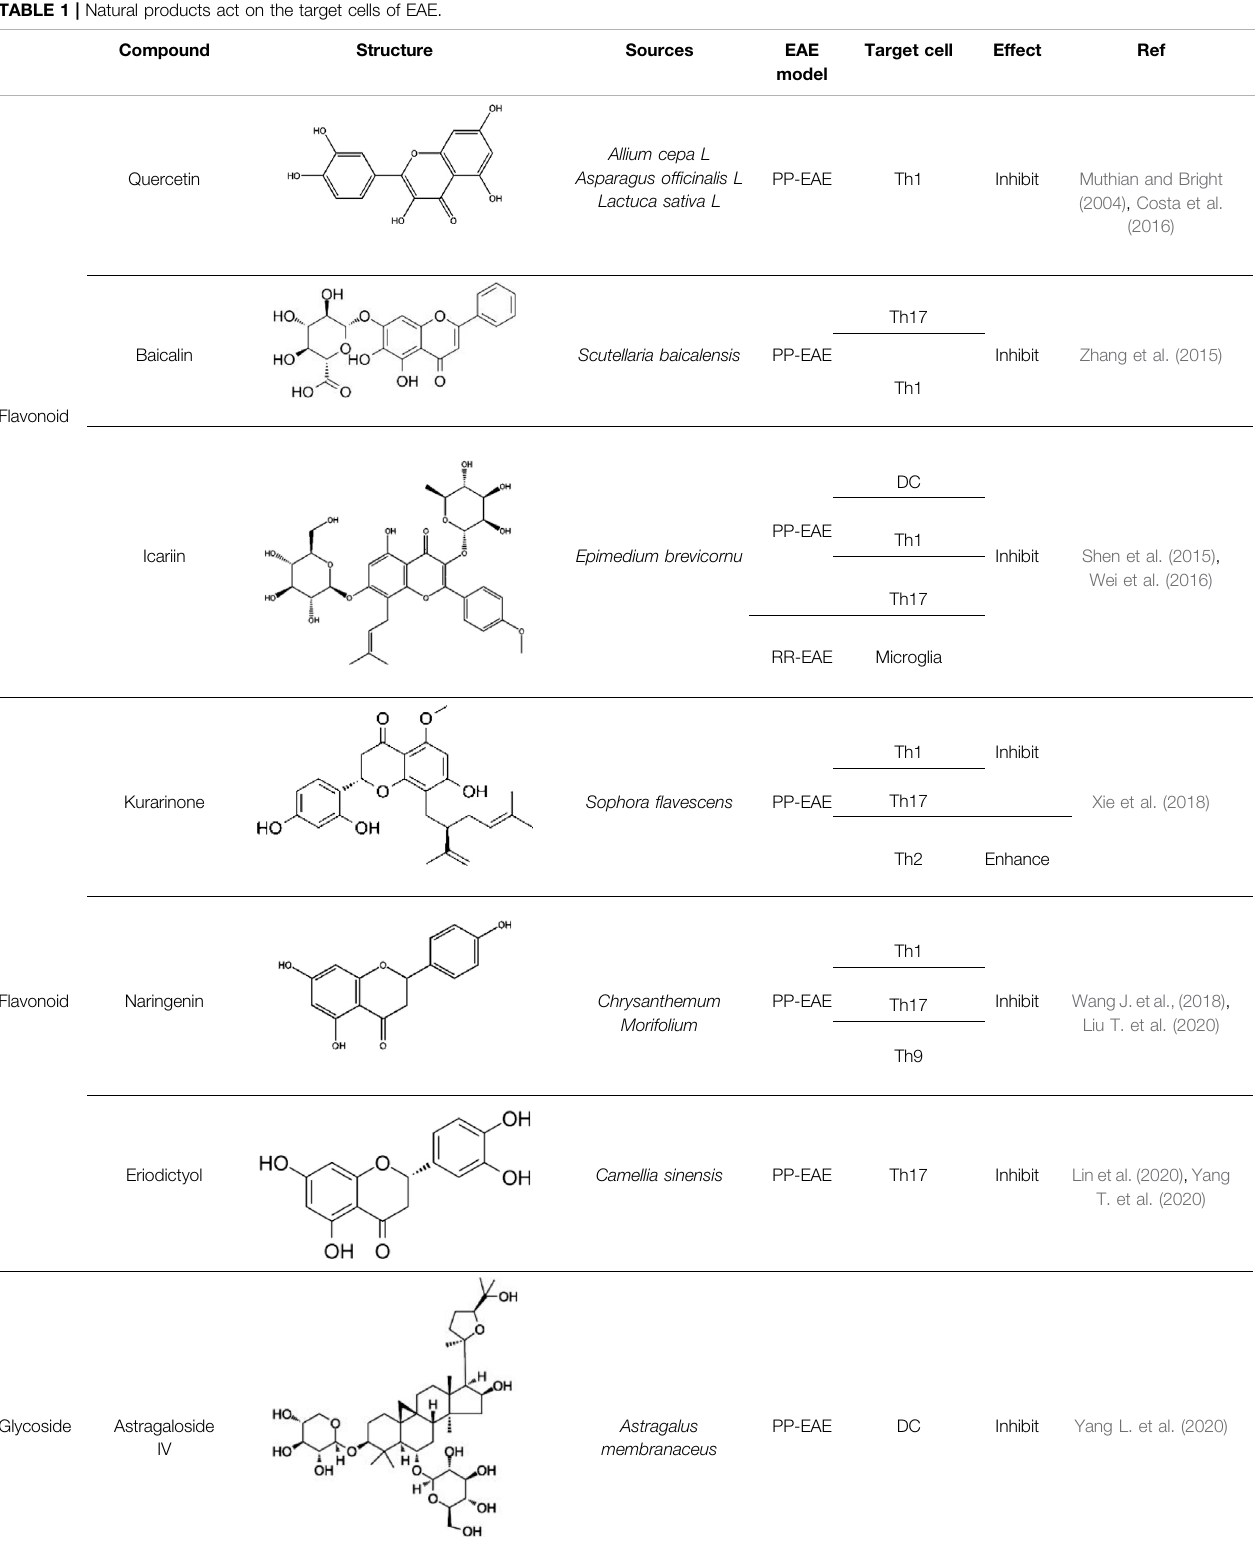
TABLE 1 | Natural products act on the target cells of